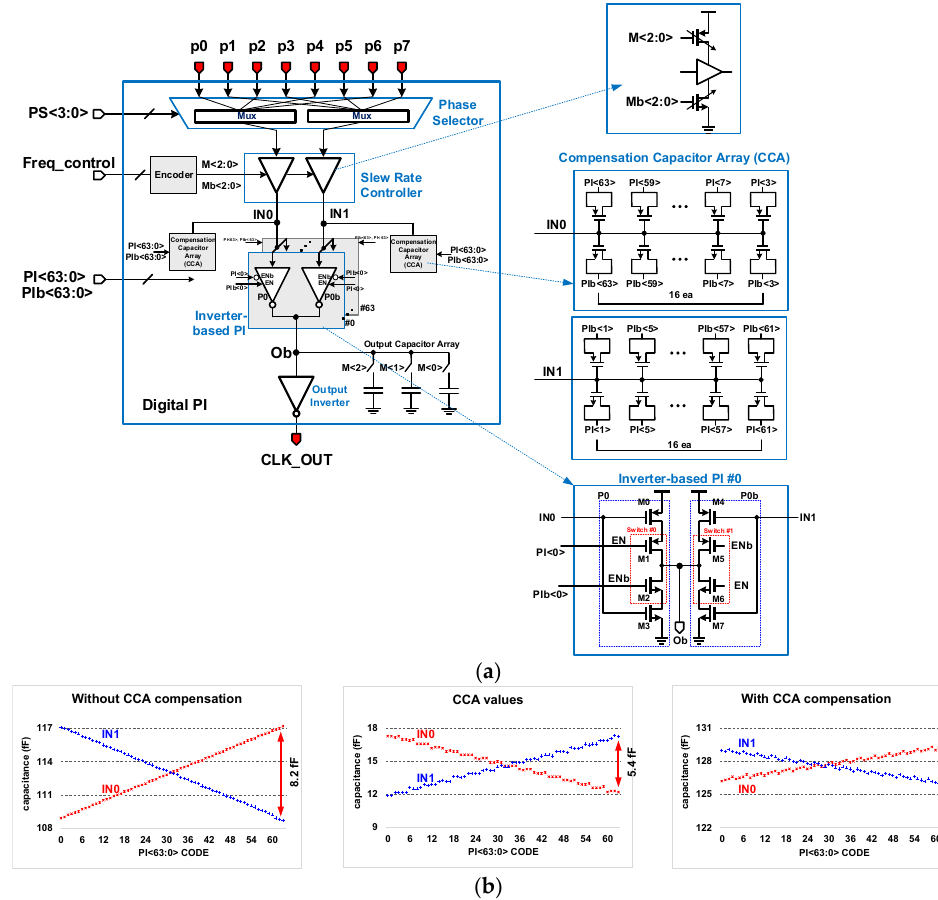
Figure 6. ( a ) Proposed digital PI. ( b ) N0/N1 node capacitance compensation using the compensation capacitor array (CCA).